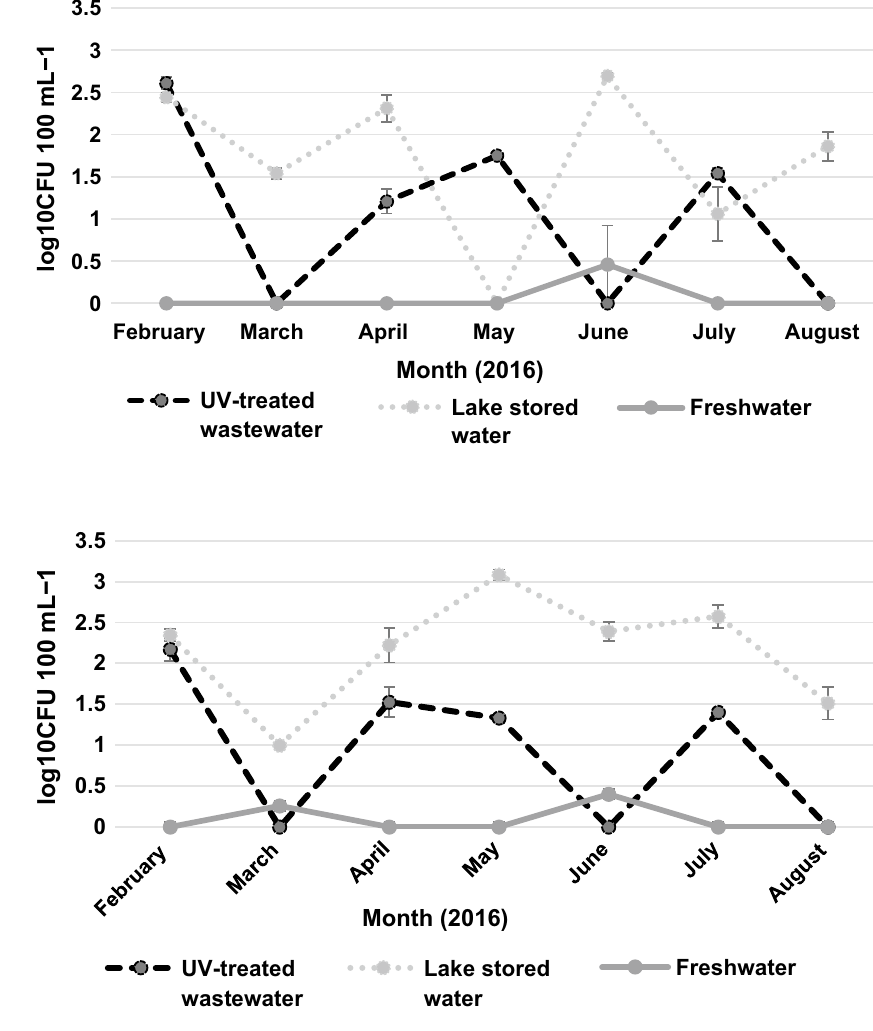
Fig. 6 Monthly variation of E. coli in the irrigation water sam- ples collected from February to August 2016